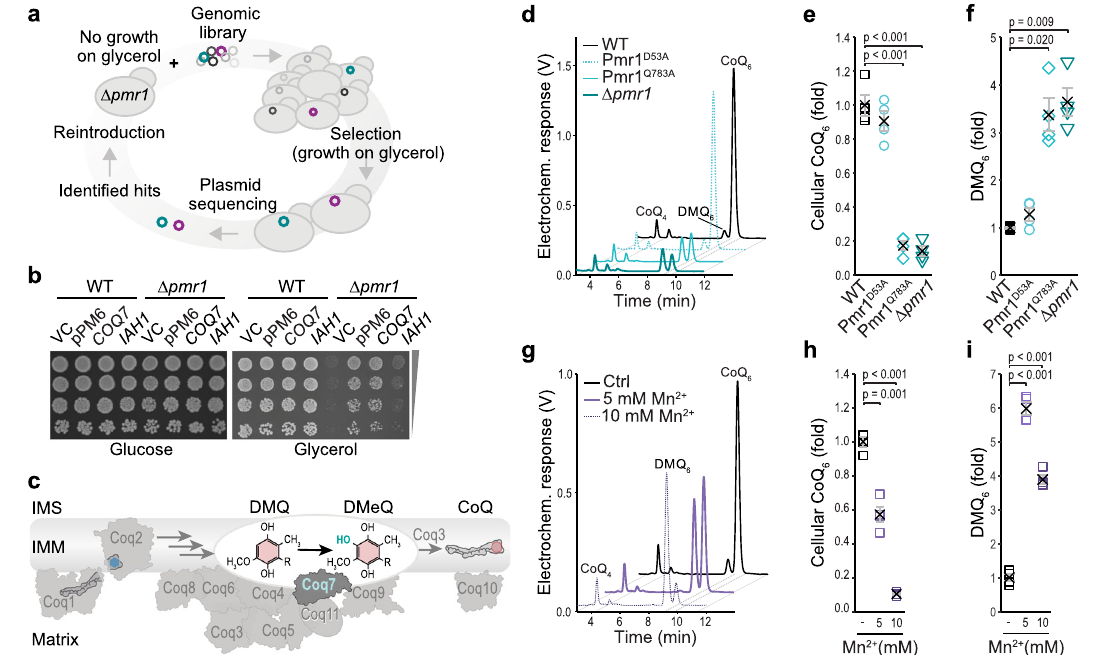
Fig. 2 | Mitochondrial dysfunction upon Mn overload is a result of CoQ de fi - ciency.a Schematicillustratingthegenome-widescreentoidentifysuppressorsof respiratory de fi ciency upon Mn overload. b Spotting of serial dilutions of Δ pmr1 cells harboring the vector control (VC), the pPM6 plasmid identi fi ed in the screen (containing a library fragment with COQ7 and IAH1 genes), or plasmids expressing COQ7 or IAH1 under their respective endogenous promoters on plates containing glucose or glycerol as indicated. c Representation of coenzyme Q (CoQ) bio- synthesis and the CoQsynthome. Coq7 catalyzes the hydroxylationofdemethoxy- CoQ (DMQ) to demethyl-CoQ (DMeQ). d – f Total cellular CoQ and DMQ content